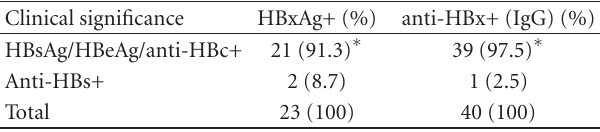
Table 2: Clinical significance of HBxAg and anti-HBx in sera Clinical